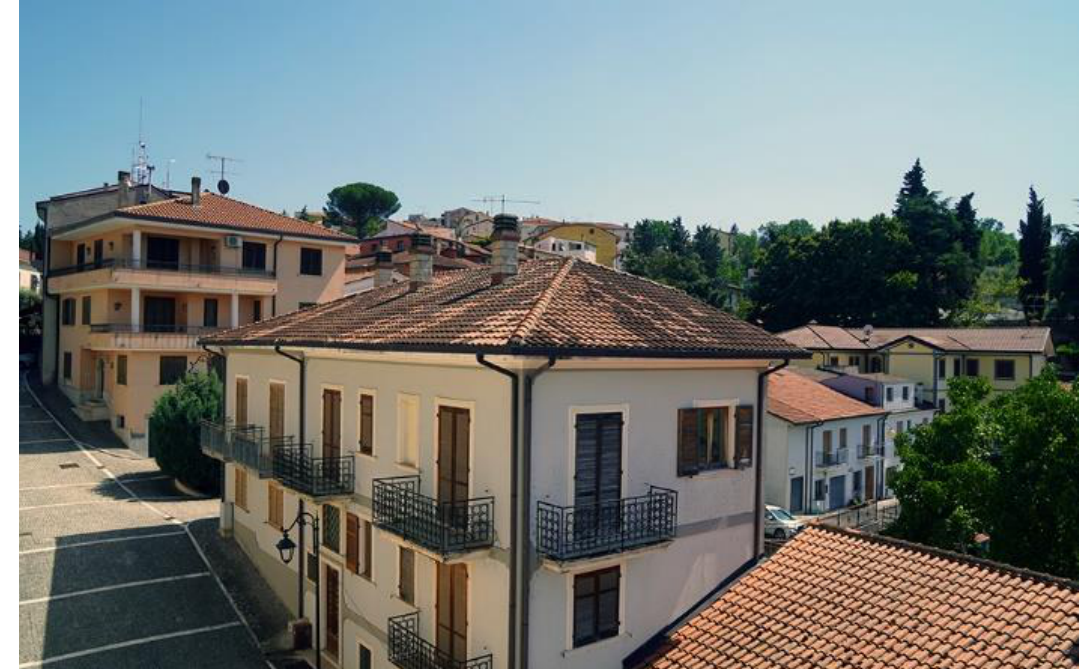
Figure 78. Torella dei Lombardi: details of the new buildings (photos by [35,36]).